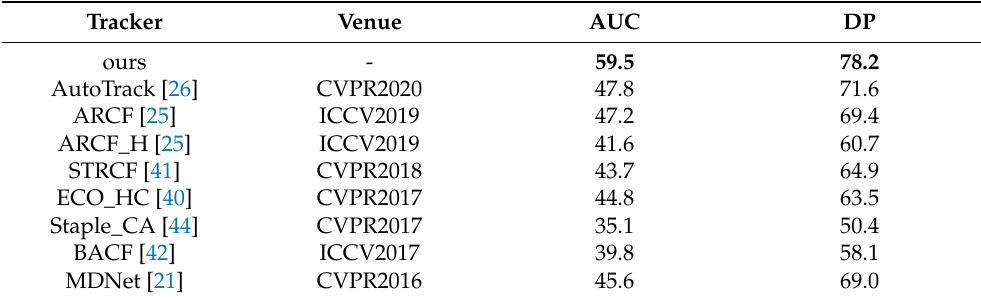
Table 7. Comparison results of the AUC score and the DP score between the proposed method and eight state-of-the-art trackers on the DTB70 dataset. Tracker